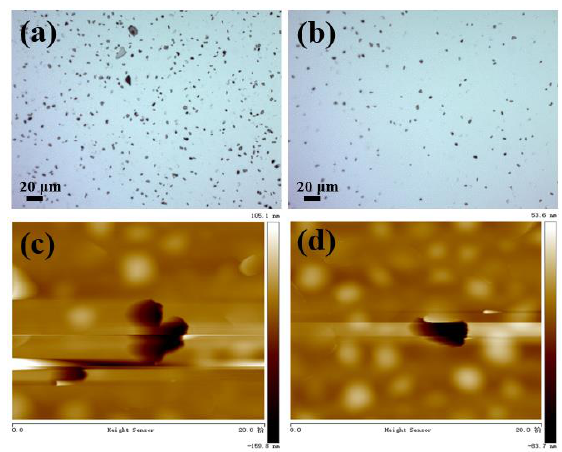
Figure 2. Surface morphology images of Samples A and B after 300 °C annealing for 1 h. ( a ) Surface morphology of Sample A; ( b ) Surface morphology of Sample B; ( c ) AFM image of the local surface morphology in Sample A; ( d ) AFM image of the local surface morphology in Sample B.